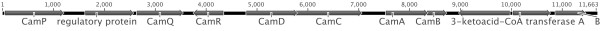
Operon of the CAM-plasmid: CamA: putidaredoxin reductase (M12546.1); CamB: putidaredoxin (J05406.1); CamC: cytochrome P-450cam (M12546.1); CamD: 5-exo-alkohol-dehydrogenase (M13471.1); CamP: 1,2-diketocamphane 2,5-monooxygenase (AY450285.1); CamQ: lactone hydrolase (AY450285); CamR: regulatory protein. The putative 3-ketoacid-CoA-transferases A and B were identified in this work by gene-walking PCR.